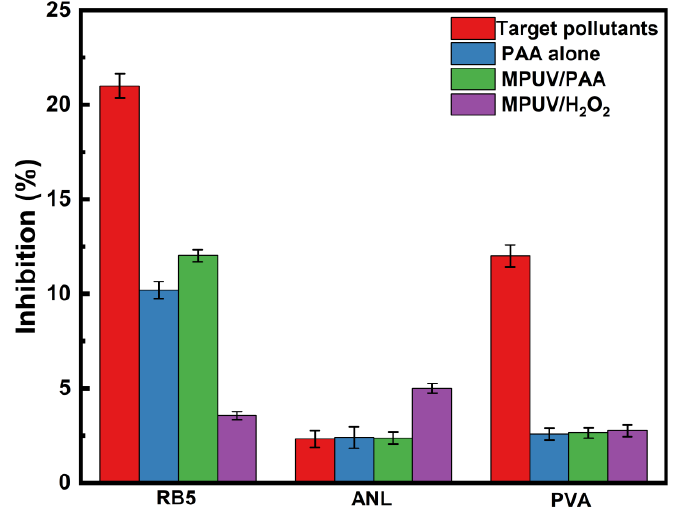
Figure 6. Acute toxicity changes of RB5, ANL, and PVA before and after degradation. Conditions: [PAA] 0 = 15 mg/L, [H 2 O 2 ] 0 = 3 mg/L, [Contaminant] 0 = 10 mg/L, pH = 7.5, T = 25 ± 1 °C, UV exposure time = 5 min.